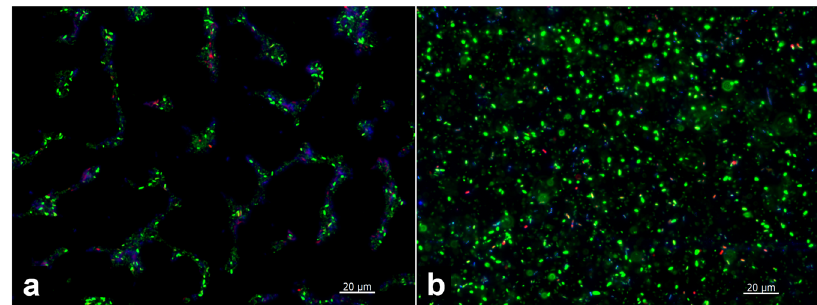
Fig. 8 In fl uence of sample treatment on visualization of a 24 h P. fl uorescens bio fi lm incubated on borosilicate glass coverslips in LBM 1:100 diluted in 0.9% NaCl. Whereas drying of the substrate during incubation and staining procedures with SYTO9/PI/ CFW was partially allowed ( a